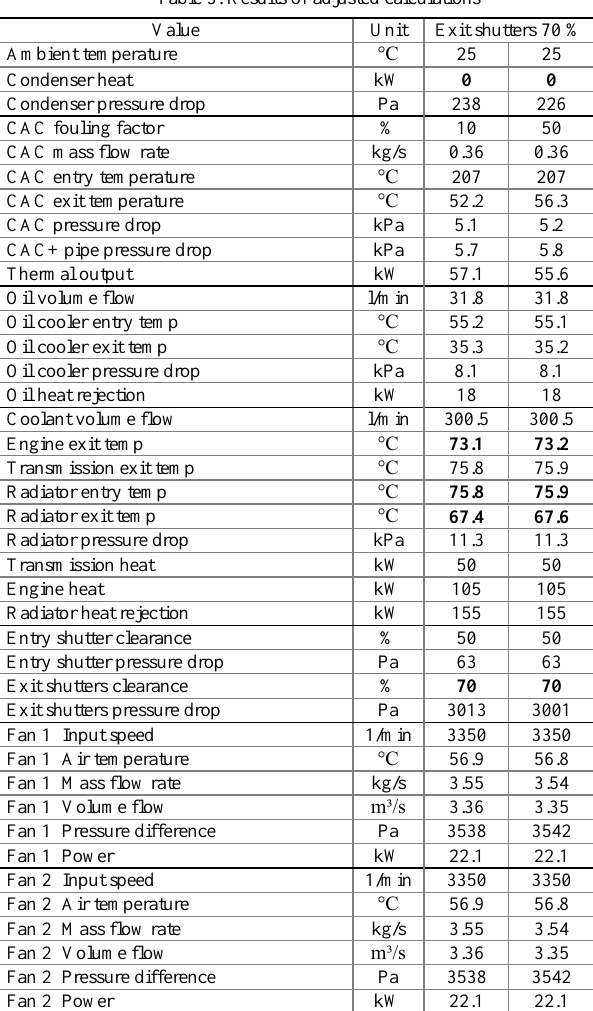
Table 3. Results of adjusted